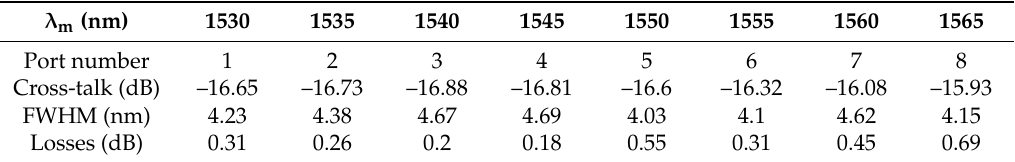
Table 3. Values of the cross-talk, full width maximum (FWHM), and losses for the operating wavelengths.